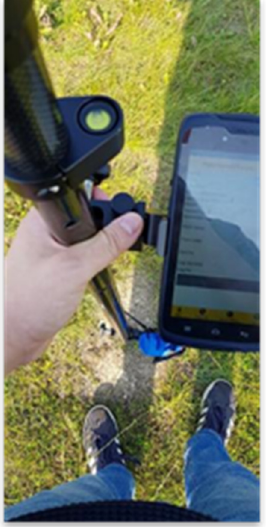
Figure 4. Static measurement with a sensor: geodetic pole with global navigation satellite system (GNSS) receiver, the gas measuring device is attached near the ground.